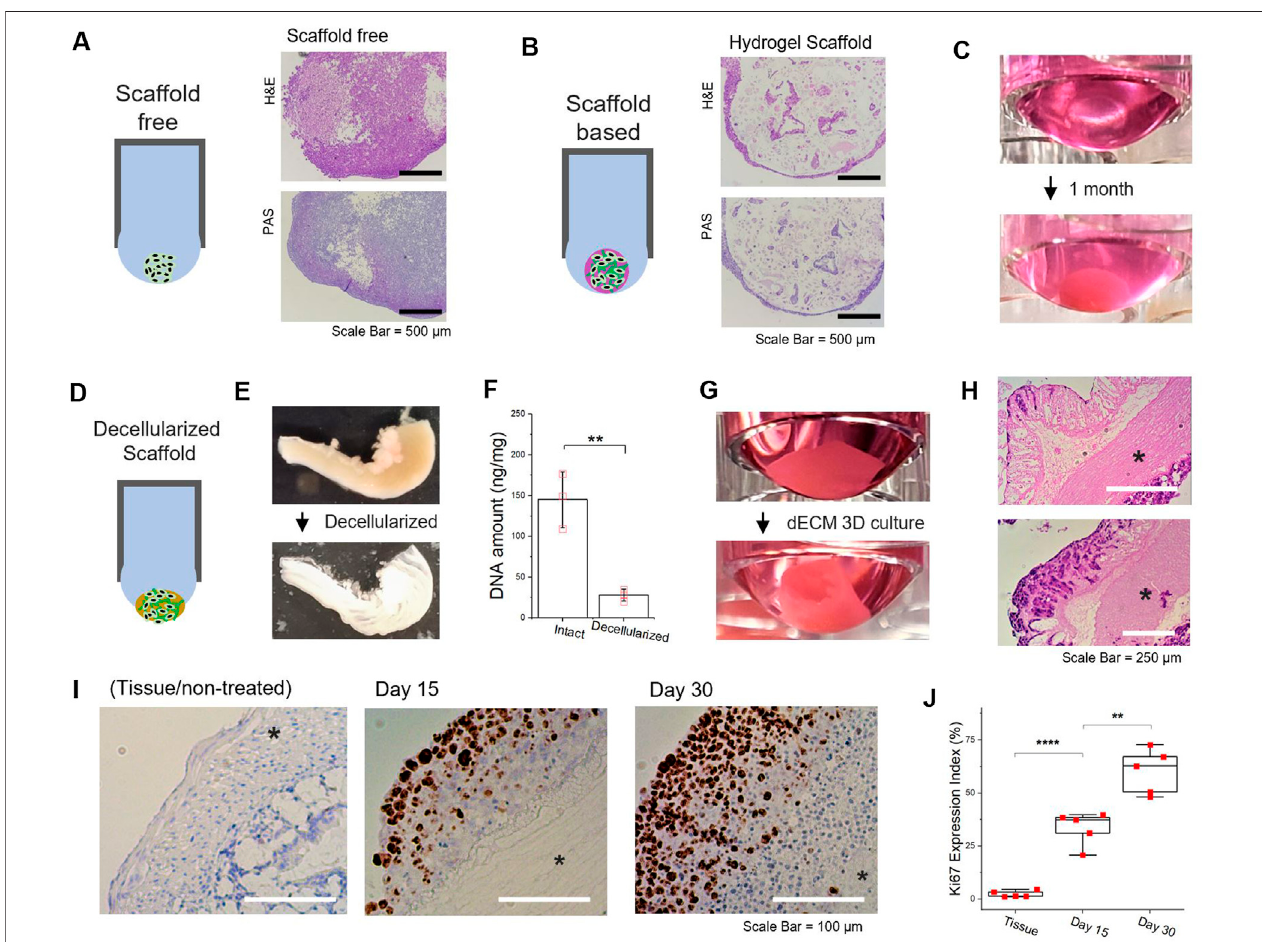
FIGURE 5 | Scaffold-free/scaffold-based 3D culture of tumor spheroid generated in hanging drop formation through well-plate fl ip. ( A,B) Comparison of scaffold- free/scaffold-based 3D spheroid and representative image of Hematoxylin and eosin (H&E) and periodic acid – Schiff (PAS) staining of scaffold-free/scaffold-based 3D HCT116 spheroid. A mixed gel of alginate (0.5 % wt) and gelatin (1 % wt) was utilized as a 3D substrate. (C) Images of 3D cell culture based on the alginate-gelatin hydrogel scaffold for 1month in hanging drop formation. (D) Schematic of decellularized scaffold-based 3D tumor spheroid generated by hanging drop formation. (E) Comparison images of decellularized mouse intestine (F) DNA quanti fi cation of mouse intestine samples, pre- and postdecellularization process. (G) Images of 3D cell culture based on the decellularized intestine for 1 month in hanging drop formation. (H) Histologic H&E analyses of decellularized intestine-based 3D tumor cell culture. upper: day 15 and lower: day 30 (*muscularis externa). (I) Immunohistochemistry images for Ki67 and hematoxylin-stained sections. Brown nuclear stain indicates Ki67 positive (left: Intestine tissue, middle: dECM-based tumor cultured for 15 days, right: dECM-based tumor cultured for 30 days) (*muscularis externa). (J) Percentage of Ki67 expression index (the fraction of Ki67-positive cells) by immunohistochemistry. Data represent mean ± SD; NS, not signi fi cant; * p < 0.05, ** p < 0.01, *** p < 0.001, and **** p < 0.0001 by Student ’ s t -test. (F) n = 3 per condition; (J) n = 5 per condition.